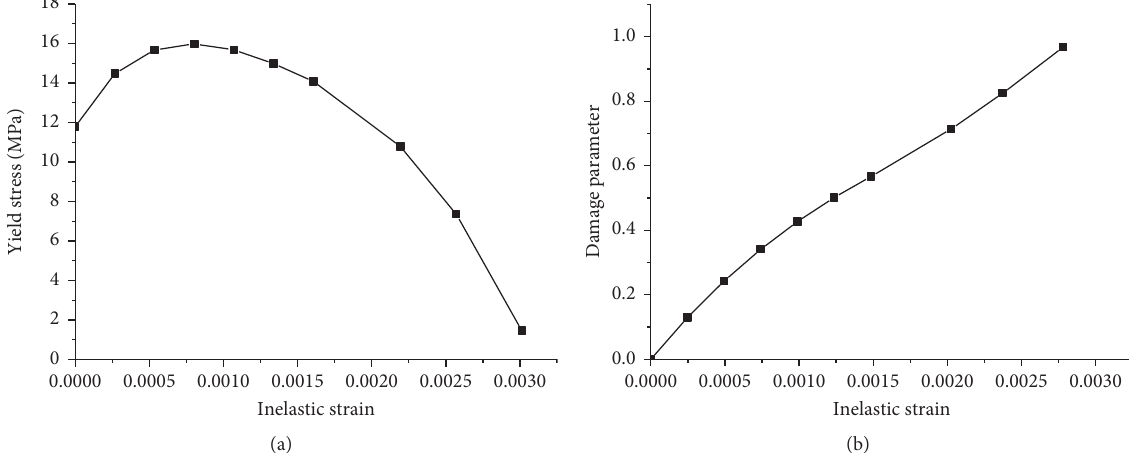
Figure 7: Dynamic compressive damage evolution curve of C